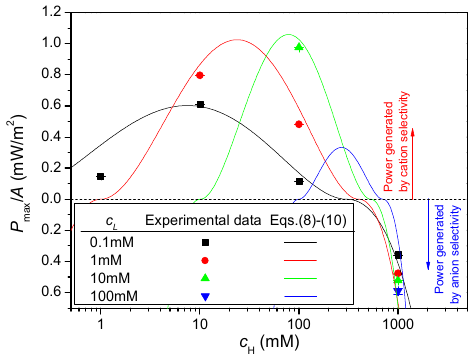
Figure 10. Maximum power generation density for various concentrations of both NaCl solutions.